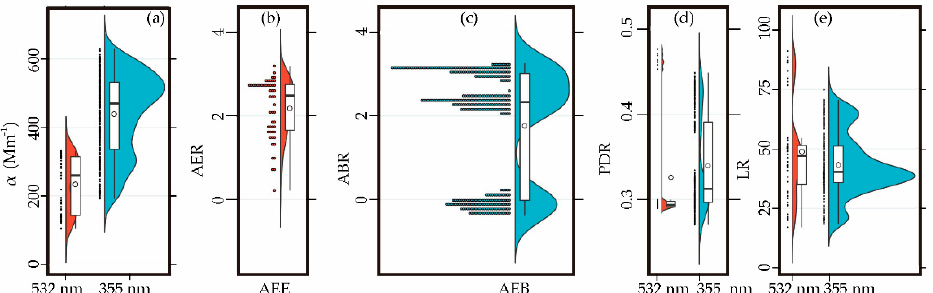
Figure 8. Statistical result of ( a ) α (Mm − 1 ), ( b ) AEE, ( c ) and Ångström exponent related to the particle backscatter coefficient (AEB), ( d ) PDR, and ( e ) LR for three selected cases. The black horizontal line in the box shows the median gene expression level in each tumor, and the upper and lower edges in the white box represent the upper and lower quartiles in the data set. The distribution of observable numerical points on the left half.